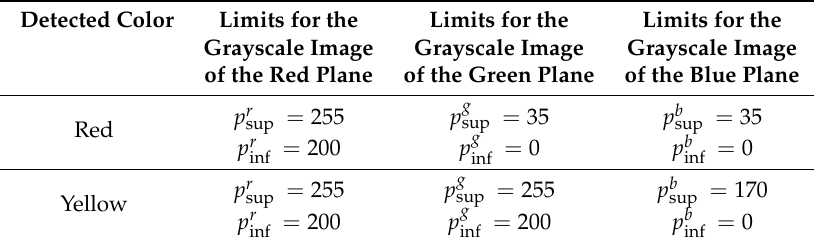
Table 4. Thresholding values to detect red and yellow colors.